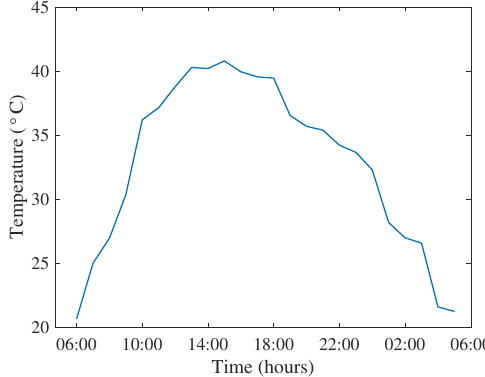
Figure 3. Ambient temperature on 8 January 2013.